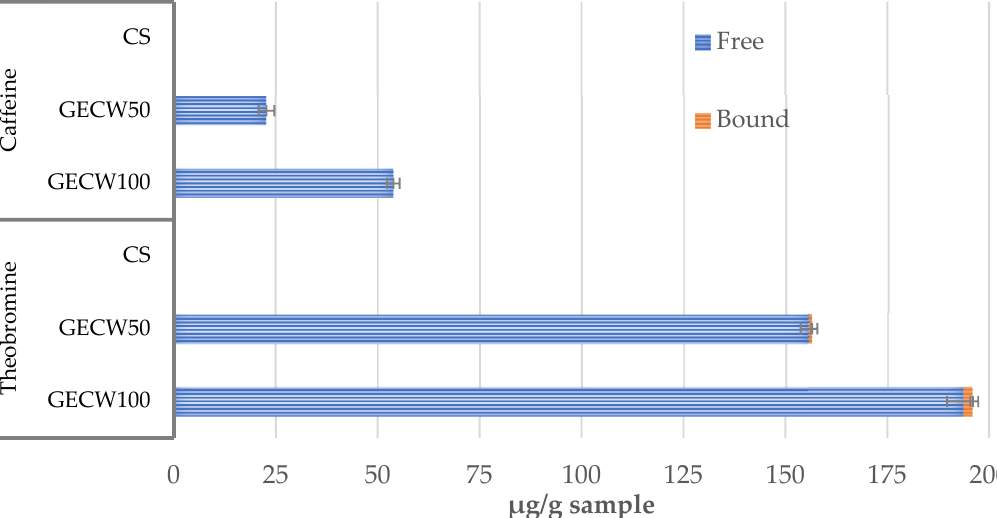
Figure 4. Bound and free methylxanthines identified in cooked beef burger elaborated with cocoa bean shell flour and walnut oil emulsion gel as partial and total pork backfat replacers. CS: control sample elaborated with the traditional formula; GECW50: sample with 50% gelled emulsion elaborated with cocoa bean shell flour and walnut oil as fat replacer; GECW100: sample with 100% gelled emulsion elaborated with cocoa bean shell flour and walnut oil as fat replacer.